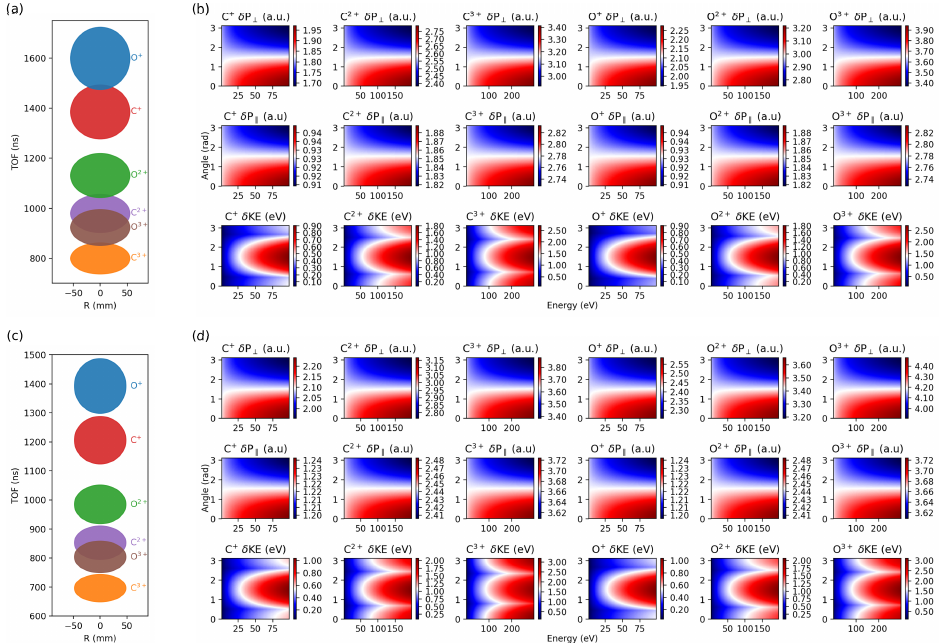
Figure 10. Simulated “TOF vs. R” ( a , c ) and ion momentum/energy resolution ( b , d ) plots for the DREAM spectrometer, with L ad = 275 mm and L a = 99 mm. Figures ( a , b ) are obtained with the spectrometer voltage setting only high enough to detect all particles over 4 π solid angle. Figures ( c , d ) are obtained by scaling up this voltage setting with a factor of 1.3. δ P (cid:107) and δ P ⊥ represent the the momentum resolution in the directions parallel and perpendicular to the spectrometer axis. δ KE represents the ion kinetic energy resolution.